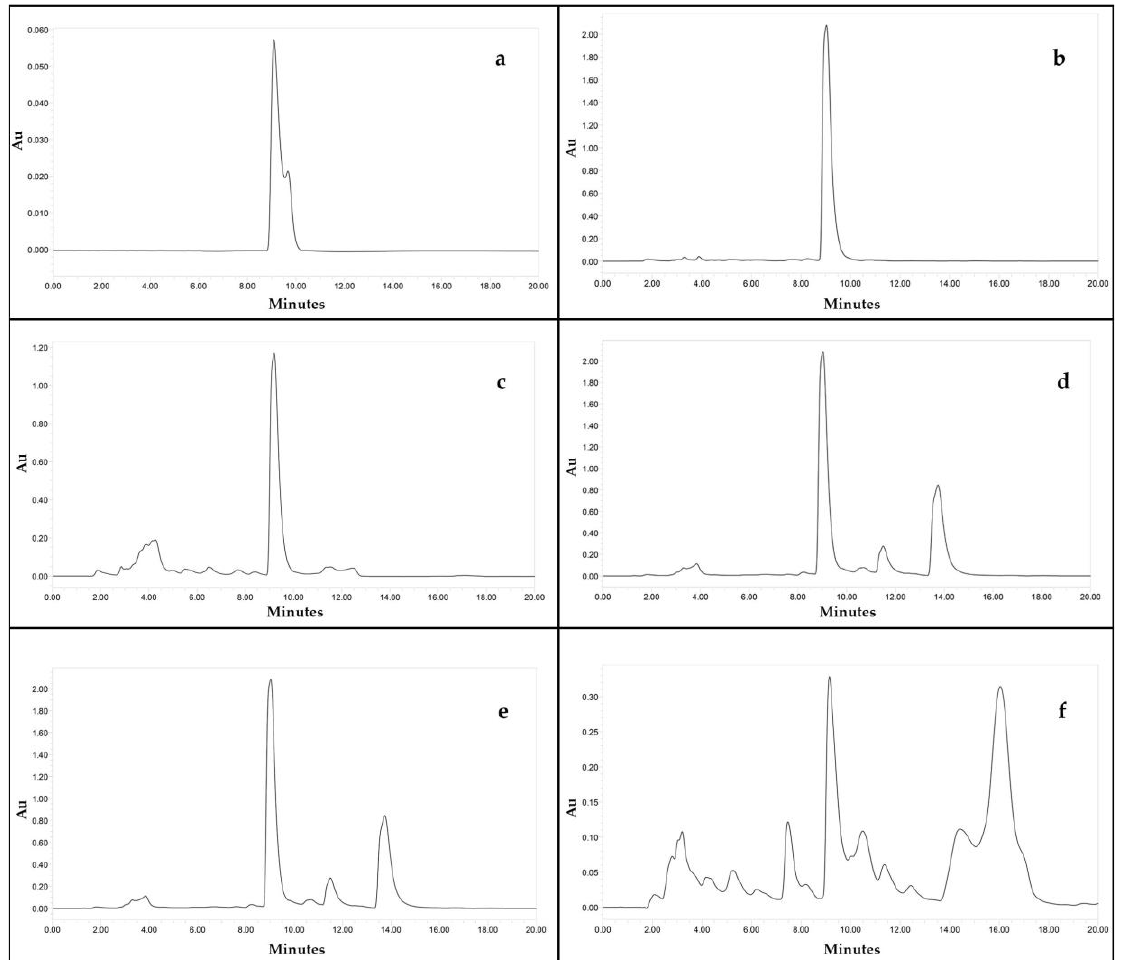
Figure 5. HPLC chromatograms of ( a ) standard beauvericin (500 µ g/mL) ( b ) Fusarium fabacearum NFCCI 5200 extract ( c ) F. sacchari NFCCI 4889 extract ( d ) F. carminascens NFCCI 5204 extract ( e ) F. tardicrescens NFCCI 5201 extract ( f ) F. cugenangense NFCCI 2872